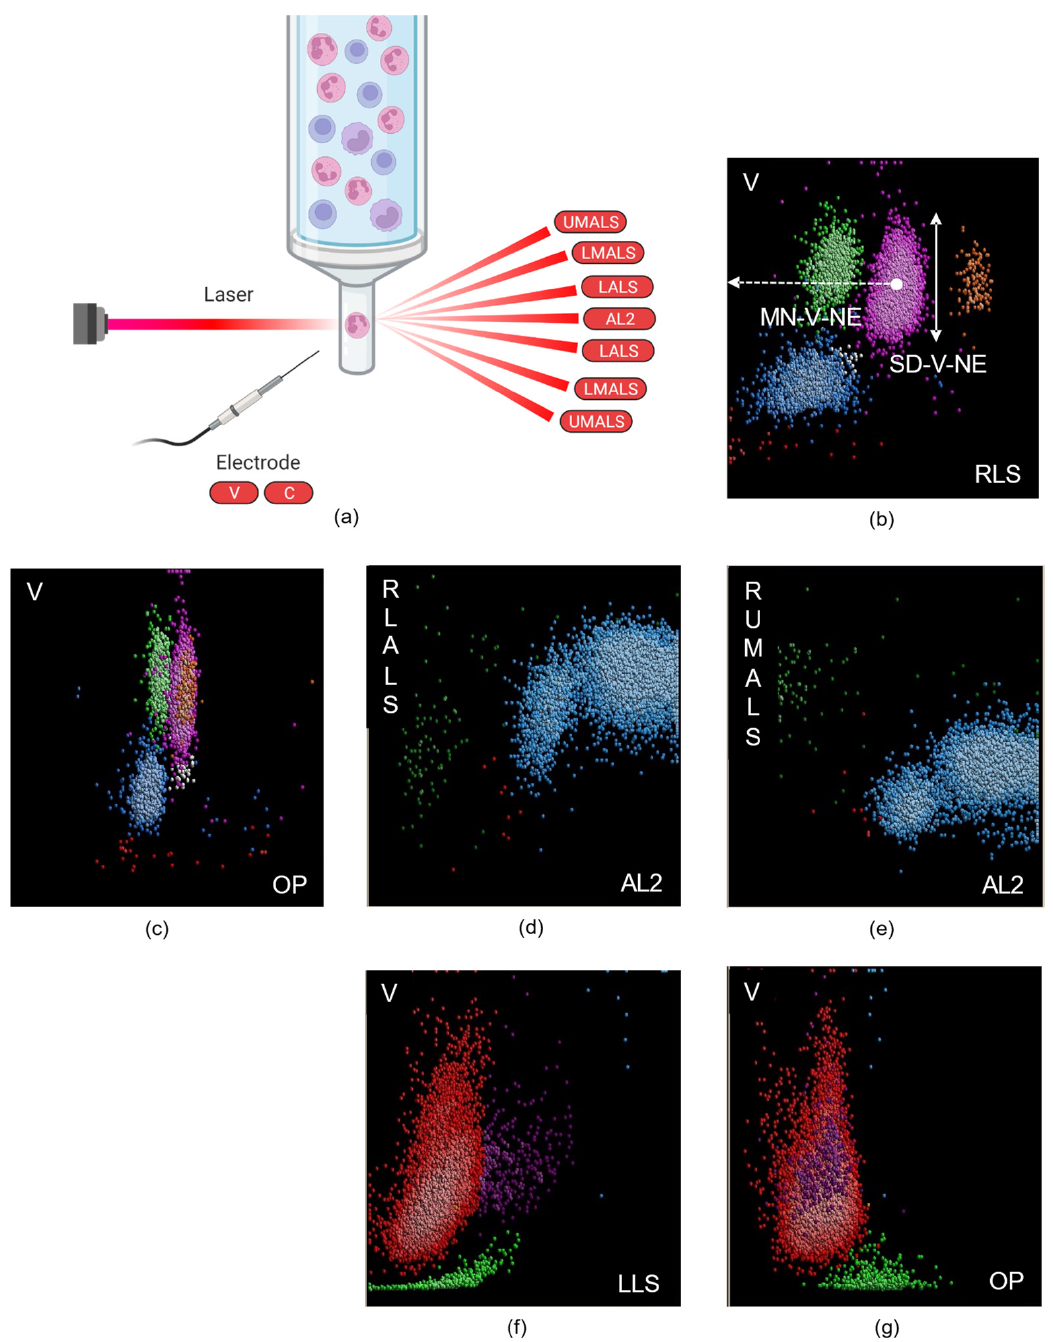
Figure 1. Illustration of the Coulter technology. ( a ) The Coulter UniCel DxH 800 analyzer measures cell volume (V) through the V impedance and the internal complexity or opacity (OP) of the cell with the C radio frequency. The light scattering is measured at different angles: upper-median-angle light scatter (UMALS), lower-median-angle light scatter (LMALS), low-angle light scatter (LALS) and axial-loss light scatter (AL2). The fifth light scatter channel, median-angle light scatter (MALS), is the sum of the UMALS and LMALS regions. For each parameter, mean (MN) and standard devi- ation (SD) are collected as cell population data (CPD). Created with BioRender.com. ( b ) Leukocyte differential: scatterplot of volume (V) versus rotated light scatter (RLS) identifies five subpopula- tions: neutrophils (NEs) in pink, eosinophils in orange, basophils in white, lymphocytes in blue and monocytes in green. CPD from volume are illustrated: MN-V-NE (dotted arrow) represents the mean channel value of NE population volume, SD-V-NE (vertical arrow) represents the standard deviation of volume for this population. ( c ) Leukocyte differential: scatterplot of volume (V) versus opacity (OP). Neutrophils, eosinophils and basophils have a similar opacity but basophils have a decreased volume. ( d ) Nucleated red blood cell (NRBC) plot: scatterplot of rotated low-angle light scatter (RLALS) versus axial-loss light scatter (AL2) showing in blue the leukocytes, in green macro- platelets and platelet clumps (and debris) and a few sparse red events corresponding to NRBCs. ( e ) Nucleated red blood cell (NRBC) plot : scatterplot of reflected upper-median-angle light scatter